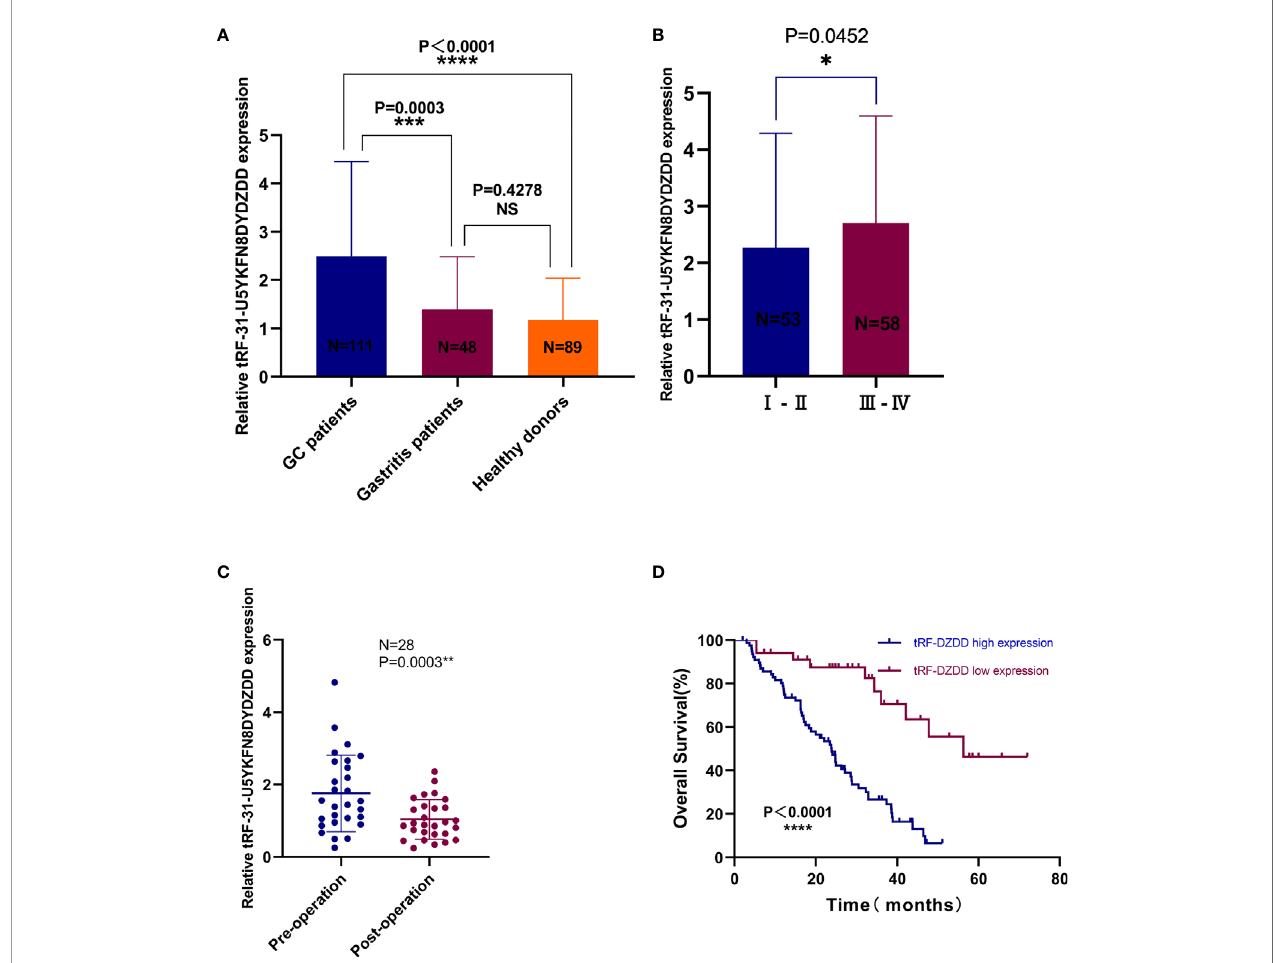
FIGURE 4 | Expression of tRF-31-U5YKFN8DYDZDD in GC serum. (A) The expression of tRF-31-U5YKFN8DYDZDD expression levels between GC (n = 111), gastritis patients (n = 48), and healthy volunteers (n = 89). (B) The expression levels of tRF-31-U5YKFN8DYDZDD in different pathologic stages of GC patients (stage I – II, n = 53; stage III – IV, n = 58). (C) Paired comparison of tRF-31-U5YKFN8DYDZDD in 28 pairs of preoperative and postoperative patients ’ serums was determined using qRT-PCR. (D) Kaplan – Meier survival curves for 111 GC patients according to tRF-31-U5YKFN8DYDZDD expression status (log-rank test, P <